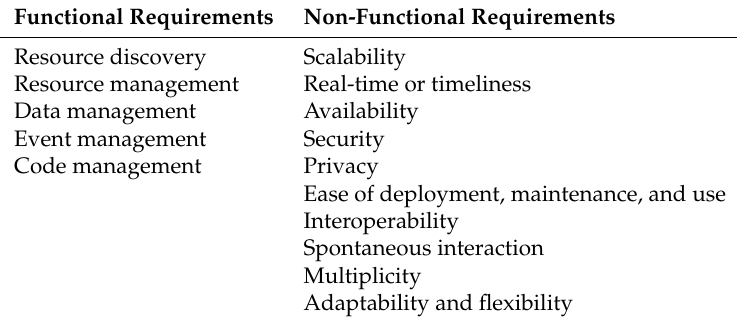
Table 1. Functional and non-functional requirements for IoT middleware